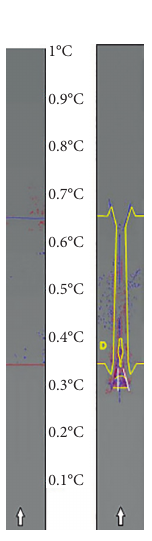
Figure 9. Representation of detachment and reattachment regions over the wing without (left) and with (right) VG in Rec = 2.38 × 10 5 and AoA =